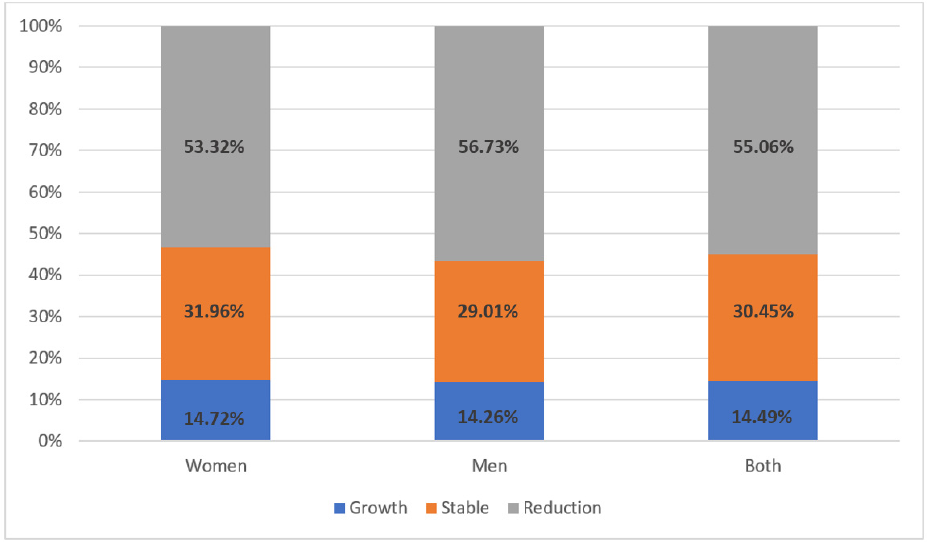
Figure 7. Change in body weight in studied population according to gender (visit 1–visit 2).